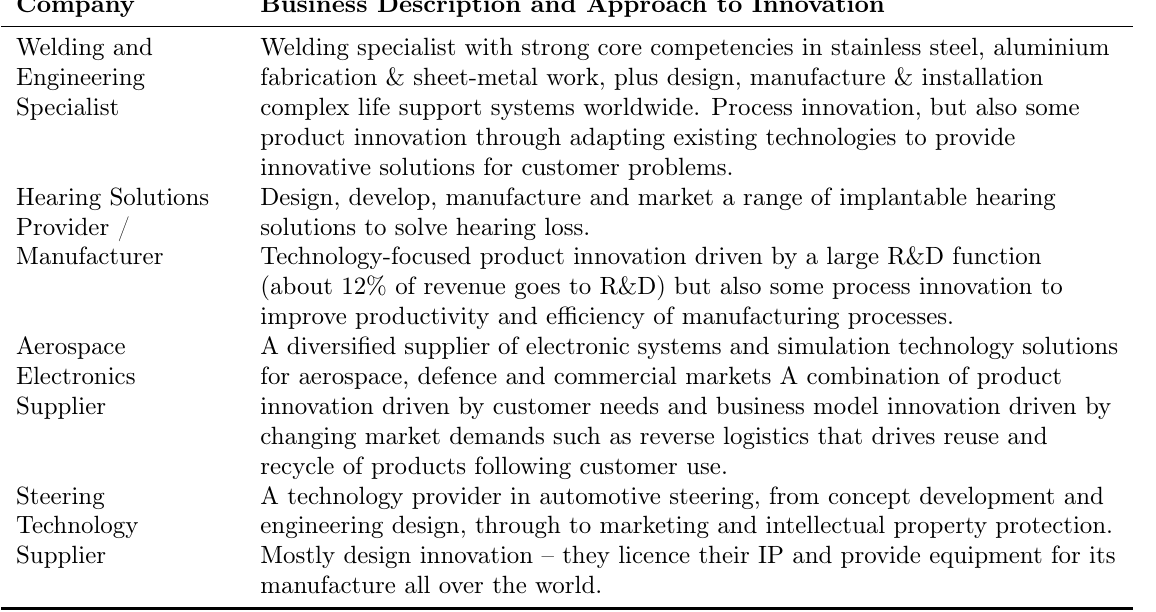
Table 5. A Food Sector Case Study: Evolving Business